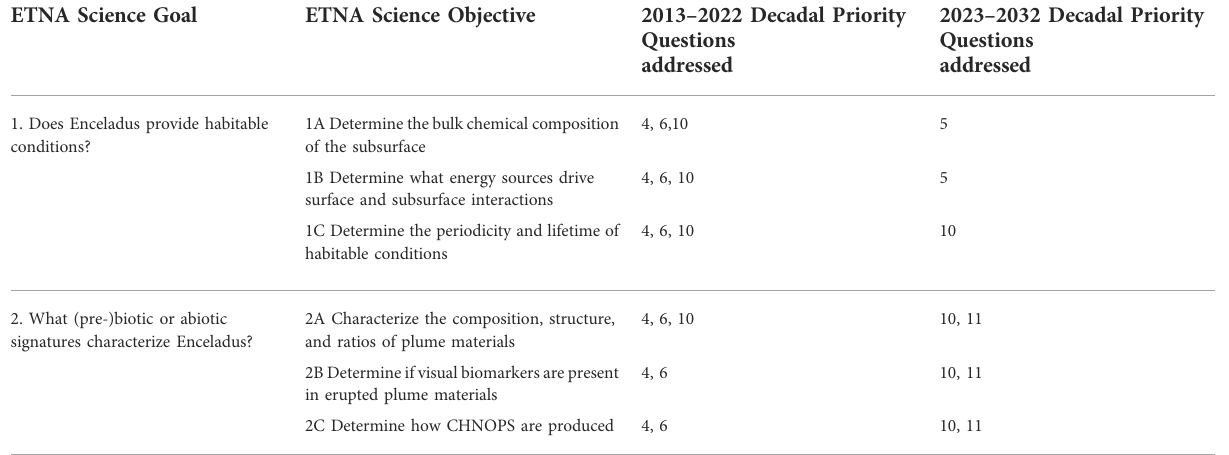
TABLE 1 ETNA Science Goals and Objectives, and their relevance to Decadal Survey Priority